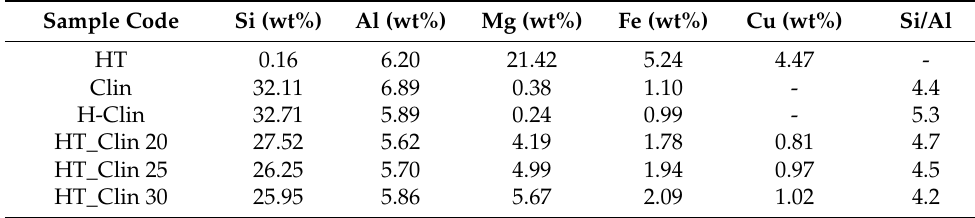
Table 1. Chemical composition of the materials determined by ICP-OES.